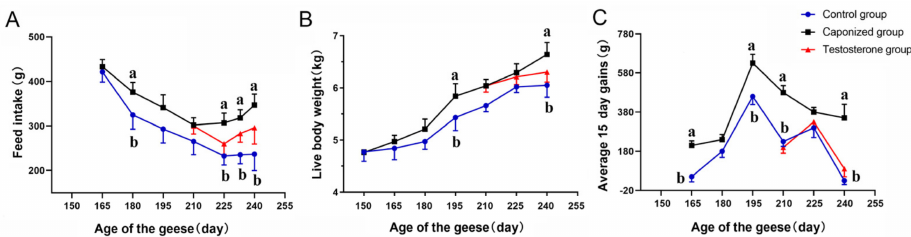
Figure 1. Feed intake ( A ), live body weight ( B ), and average 15 day gains ( C ) of the control group ( • ), the caponized group ( (cid:4) ), and the testosterone group ( (cid:78) ). Data are shown as mean values ± standard error of the mean. Different letters above the bars denote significant differences ( p <